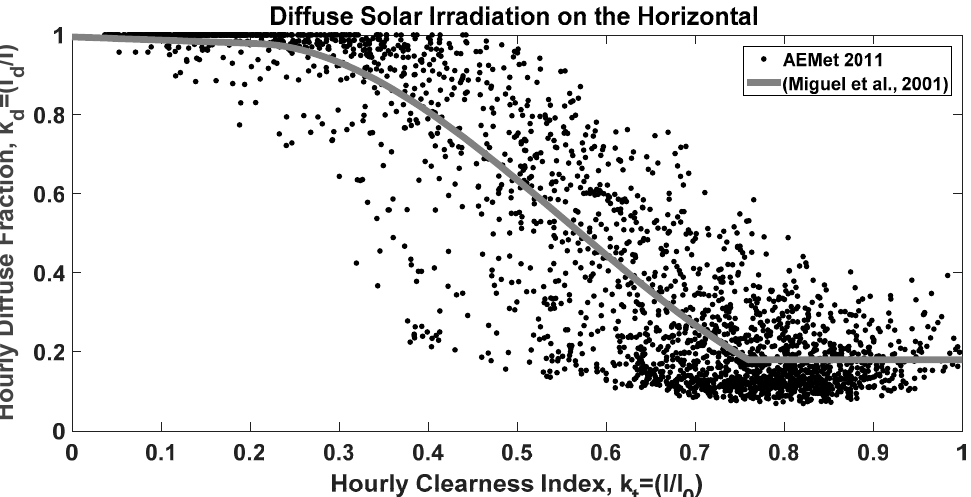
Figure 4. AEMet data from La Virgen del Camino (León, Castile and León region, Spain) for the hourly diffuse fraction vs. the hourly clearness index for the eight central hours of the day during the year 2011, along with the horizontal diffuse solar irradiation estimation model (Miguel et al. [43]).